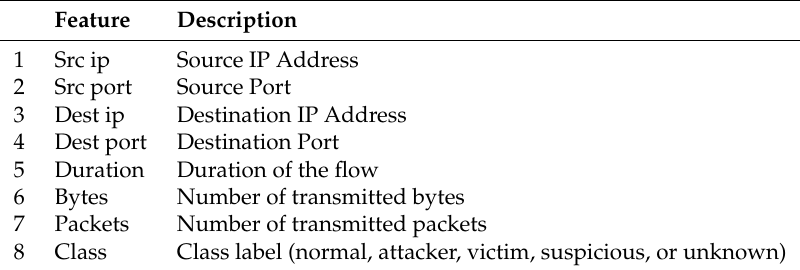
Table 4 details each feature after the removal of noisy elements. Table 4. Features used in CIDDS-001